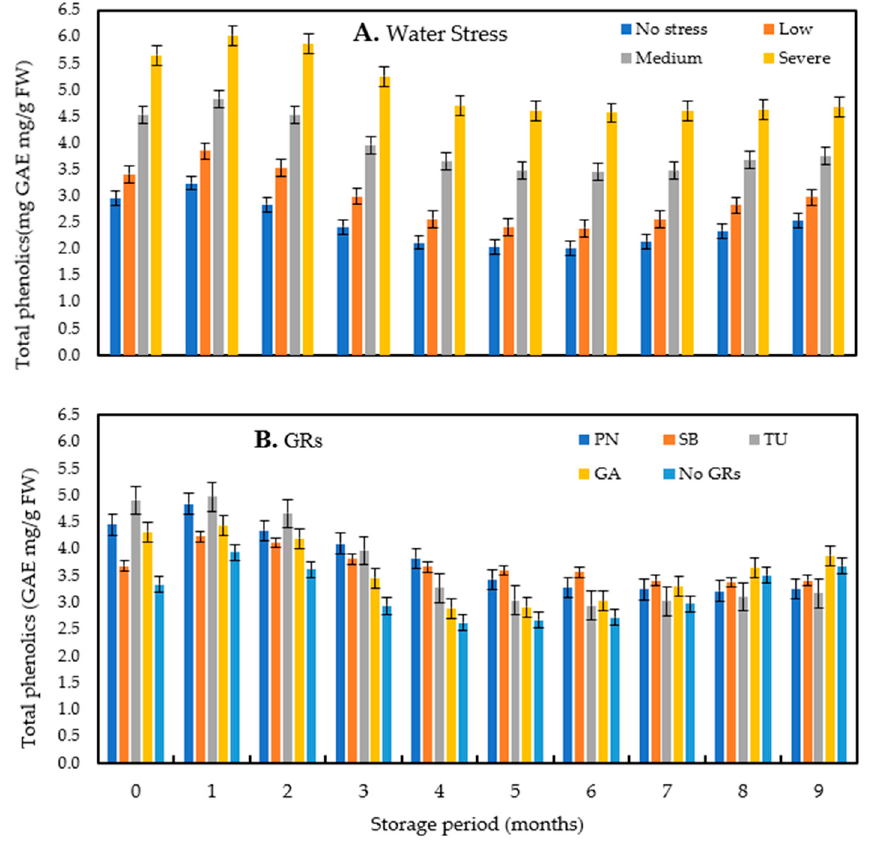
Figure 4. Effect of water stress on total phenolics ( A ) and growth regulators (GRs) ( B ) across nine months of storage.